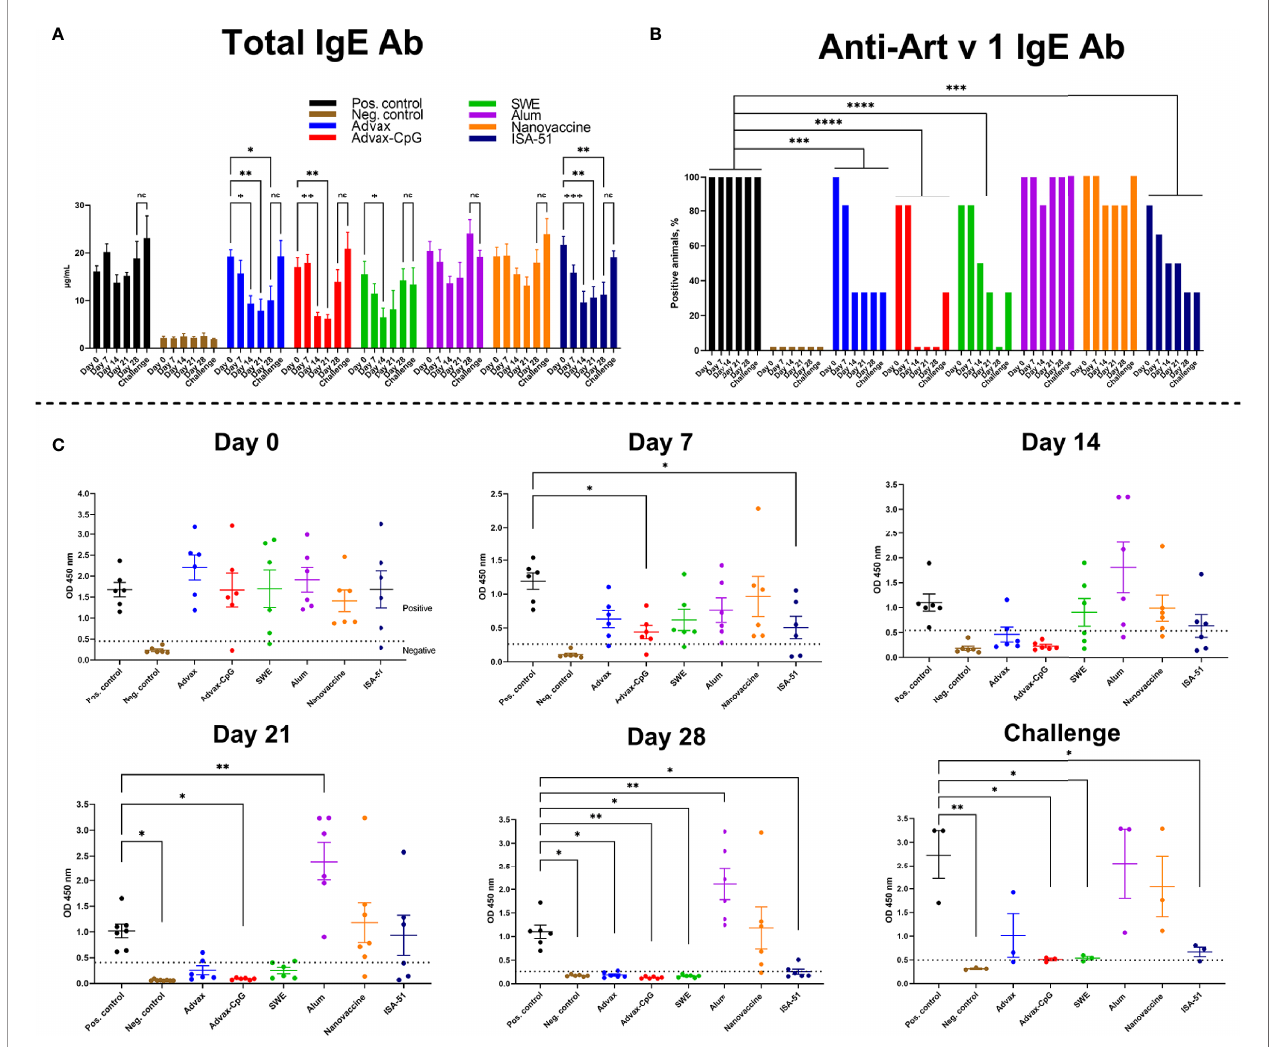
FIGURE 2 | Reduction after ASIT of total (A) and Art v 1-speci fi c (B, C) IgE in BALB/c mice sensitized with wormwood pollen. The number of mice positive for Art v 1-speci fi c IgE on days (0, 7, 14, 21, 28) of ASIT and after challenge was estimated and expressed in percent. ASIT was performed with increasing doses of Art v 1 protein with Advax, Advax-CpG, SWE, aluminum hydroxide, or ISA-51. A group of mice that received intranasal Art v 1 protein-loaded mannose-chitosan nanoparticle ASIT was included for comparison. Challenges were performed by combined intranasal injection and inhalation of wormwood pollen extract. Differences in IgE levels between groups and ratio of animals seropositive for Art v 1-speci fi c IgE were evaluated using Dunnett ’ s multiple comparisons test. A P value <0.05 was considered signi fi cant. *P < 0.05, **P < 0.01, ***P < 0.001, and ****P <